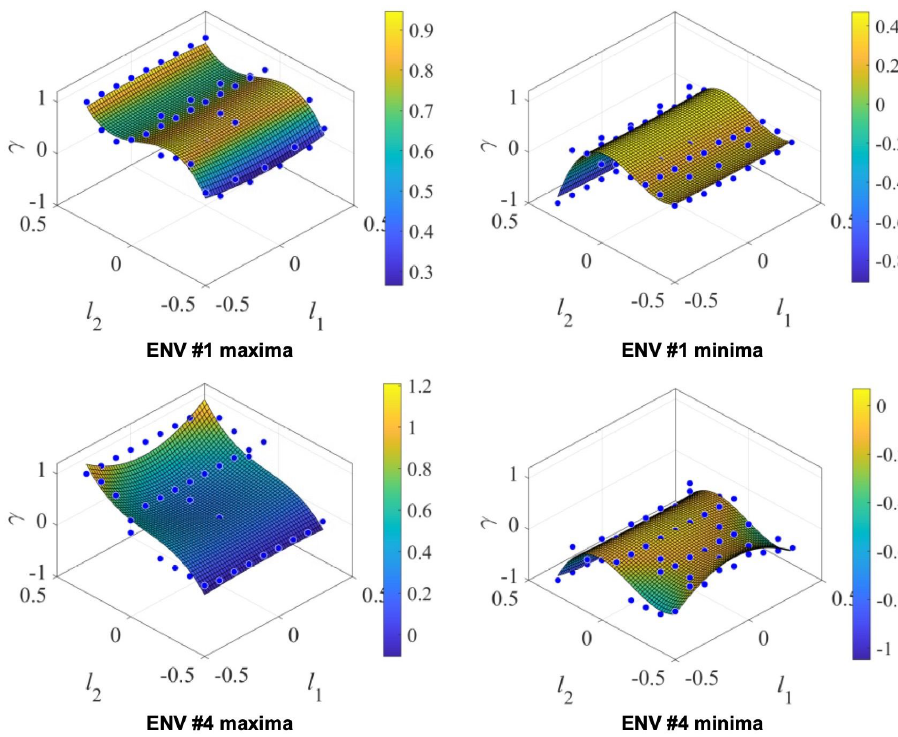
Figure 13: Examples of envelope pressure modes, 𝛾 ( x , y ) , for θ = 0 ∘